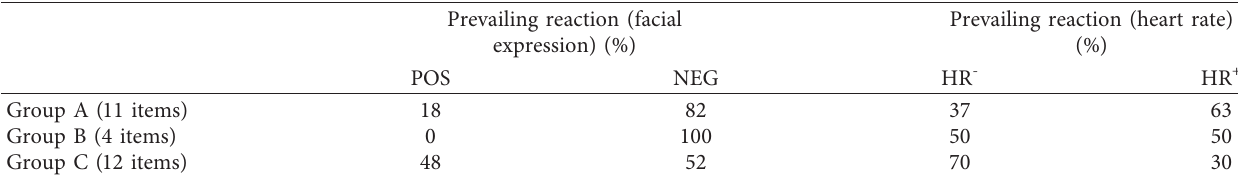
Table 1: Analysis of prevailing reactions for static VR items by subject (% values given for the